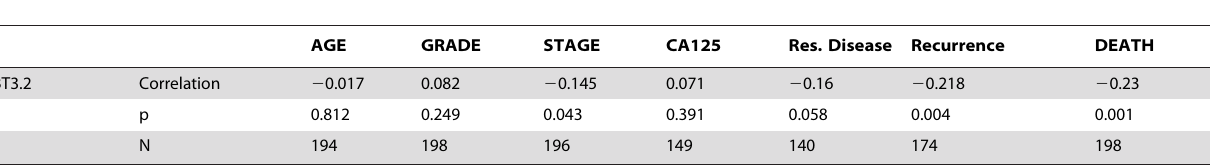
Table showing the coefficient of correlation with a Pearson correlation test (Correlation) between clinical parameters and BT3.2 staining intensity observed in the intra- epithelial area of ovarian tumor tissues. Grade and stage were evaluated according to the FIGO classification as described in Materials and Methods. Res. Disease is the amount of residual disease at primary resection of the tumor as classified in Table 1. Recurrence is the first event of ovarian cancer recurrence after the primary resection of the tumor. CA125= blood serum level CA125 at the date of primary resection of the ovarian tumor. P is the p value from Pearson correlation test. N is the number of